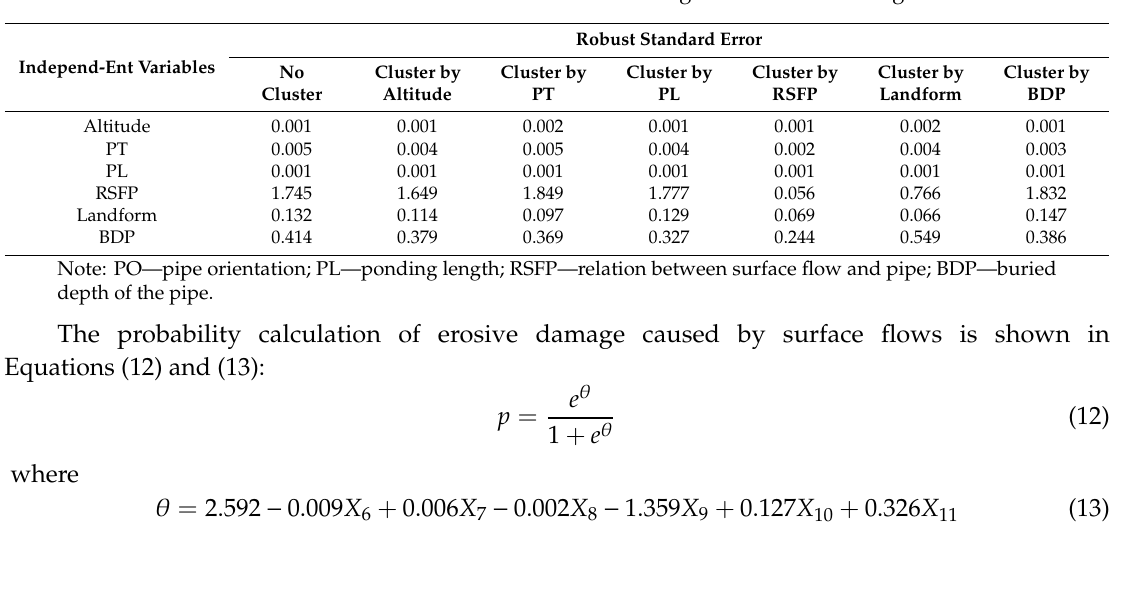
Table 7. Clustered robust standard errors of the regressed erosive